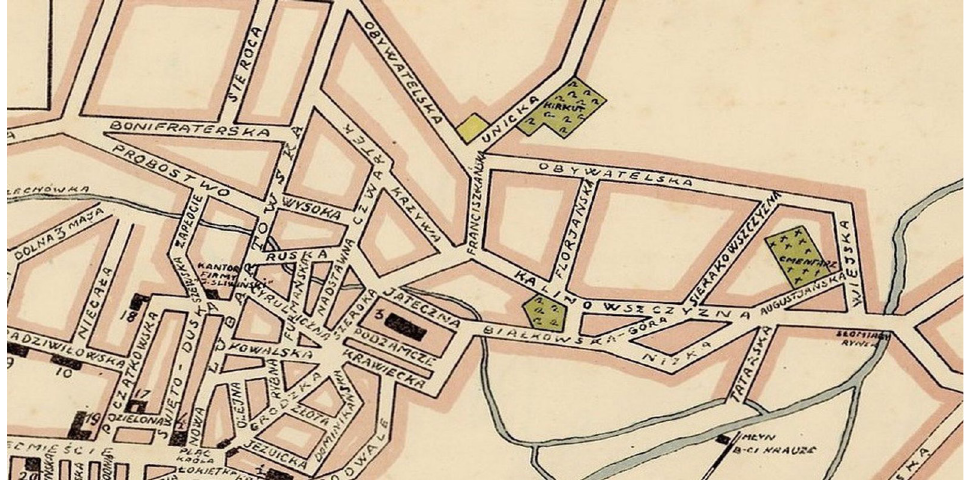
Fig. 6. Podzamcze and Franciszkańska Streets on the city map from 1931 (source: Plan Wielkiego Miasta Lublina , Biuro Regulacji Magistratu m. Lublina, original scale